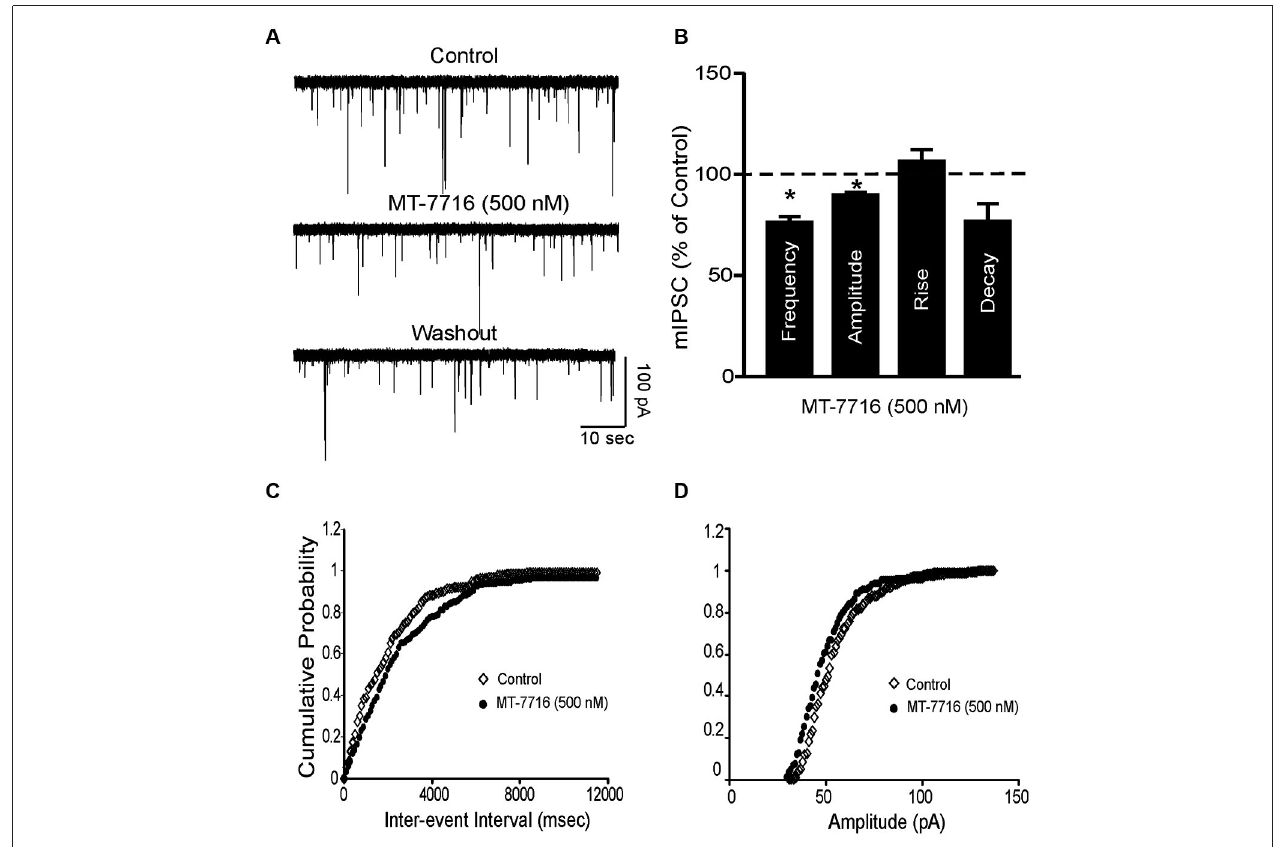
show that MT-7716 shifted the cumulative frequency to the right (in 11 out of 12 CeA neurons studied), indicating a longer inter-event interval during its application, suggesting decreased GABA release. (D) Cumulative fractions calculated by Kolmogorov-Smirnov sample test show that MT-7716 shifted the cumulative frequency to the right (in 10 out of 12 CeA neurons studied). MT-7716 shifted the cumulative amplitude to the left, indicating smaller mIPSC amplitudes, suggesting postsynaptic site of